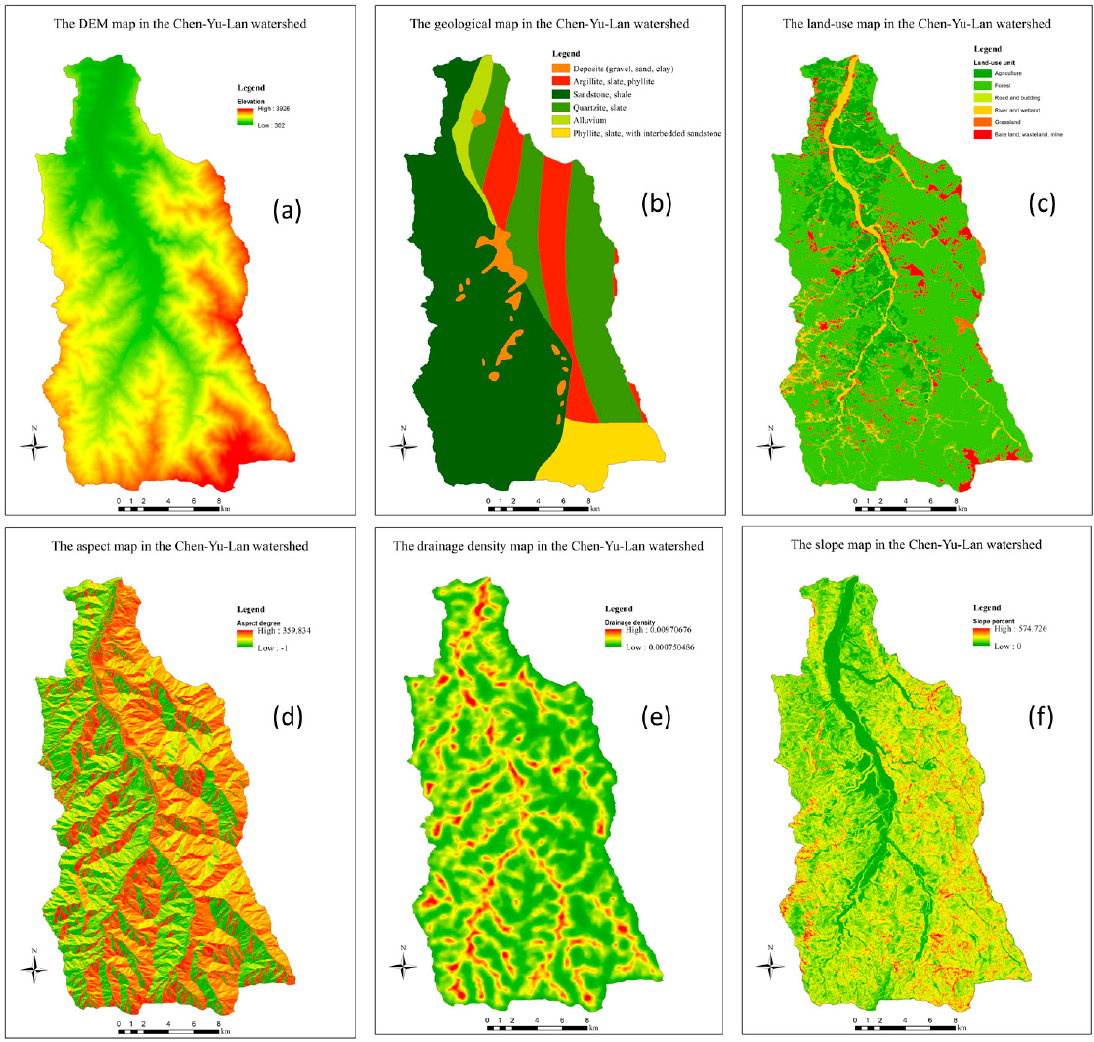
Figure 5. The material maps in the Chen-Yu-Lan watershed: ( a ) the DEM map; ( b ) the geological map; ( c ) the land-use map; ( d ) the aspect map; ( e ) the drainage density map; ( f ) the slope map.